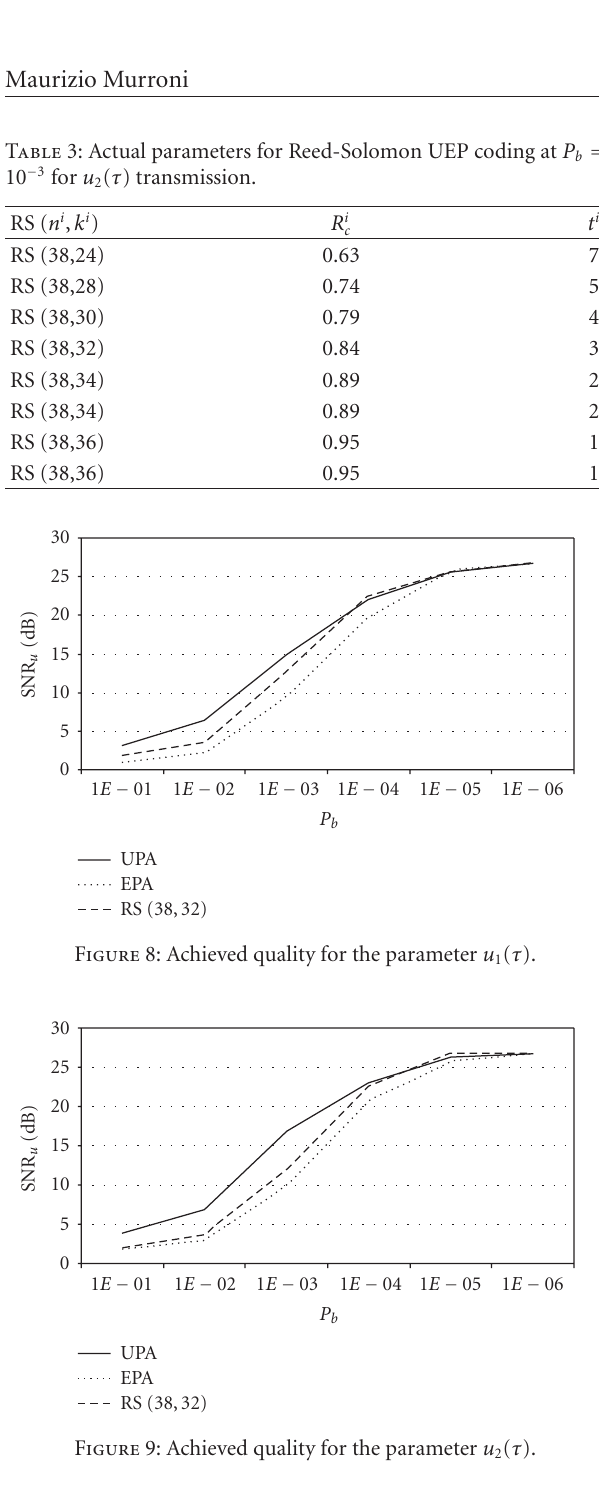
3.57 dB the peak gain for P b = 3 . 5 × 10 − 3 and for u 2 ( τ ).